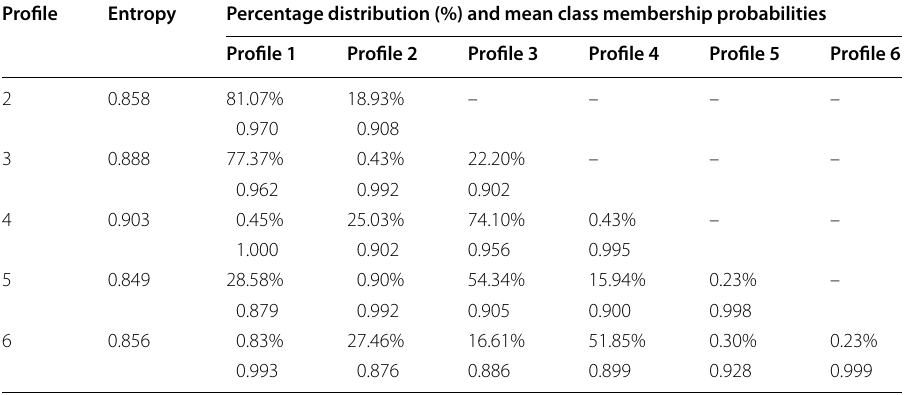
Table 2 Latent profile analysis—criteria for evaluating the model quality